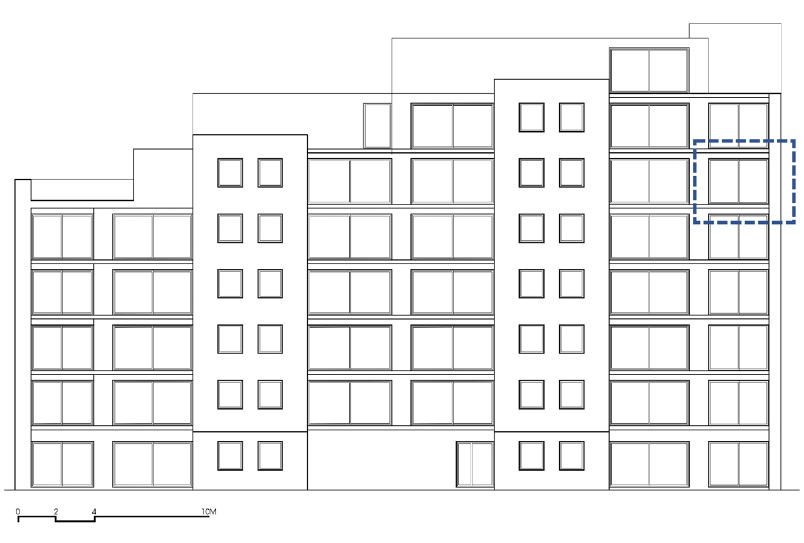
The building where Leo lives is a high-rise building on the street. The building is split into four blocks. The block, where Leo lives, accommodates 14 residents, among them one out of two good neighbors lives on the ground floor.